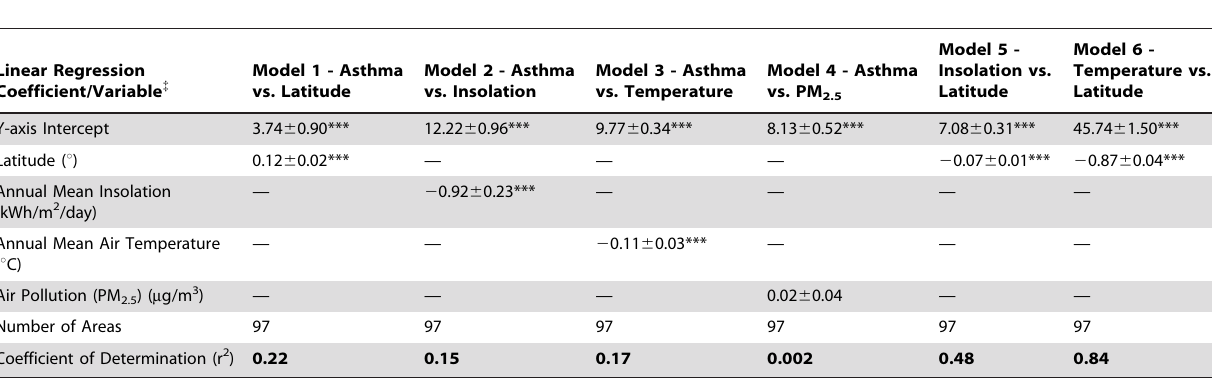
Table 1. Linear regression estimates of asthma prevalence in US adult population associated with latitude, annual mean insolation, air temperature and air pollution (PM 2.5 ).